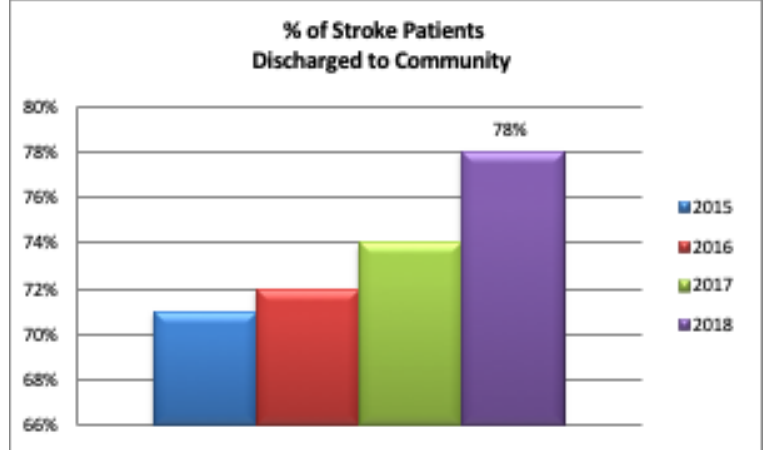
Figure 4. Percentage of patients discharged to the community 2015 through